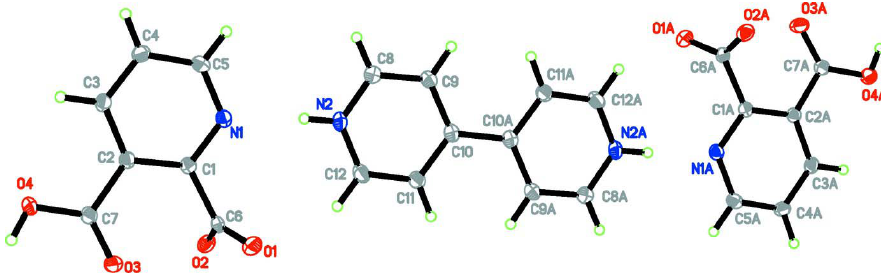
Figure 1 The molecular structure of the title compound showing the displacement ellipsoids drawn at the 50% proability